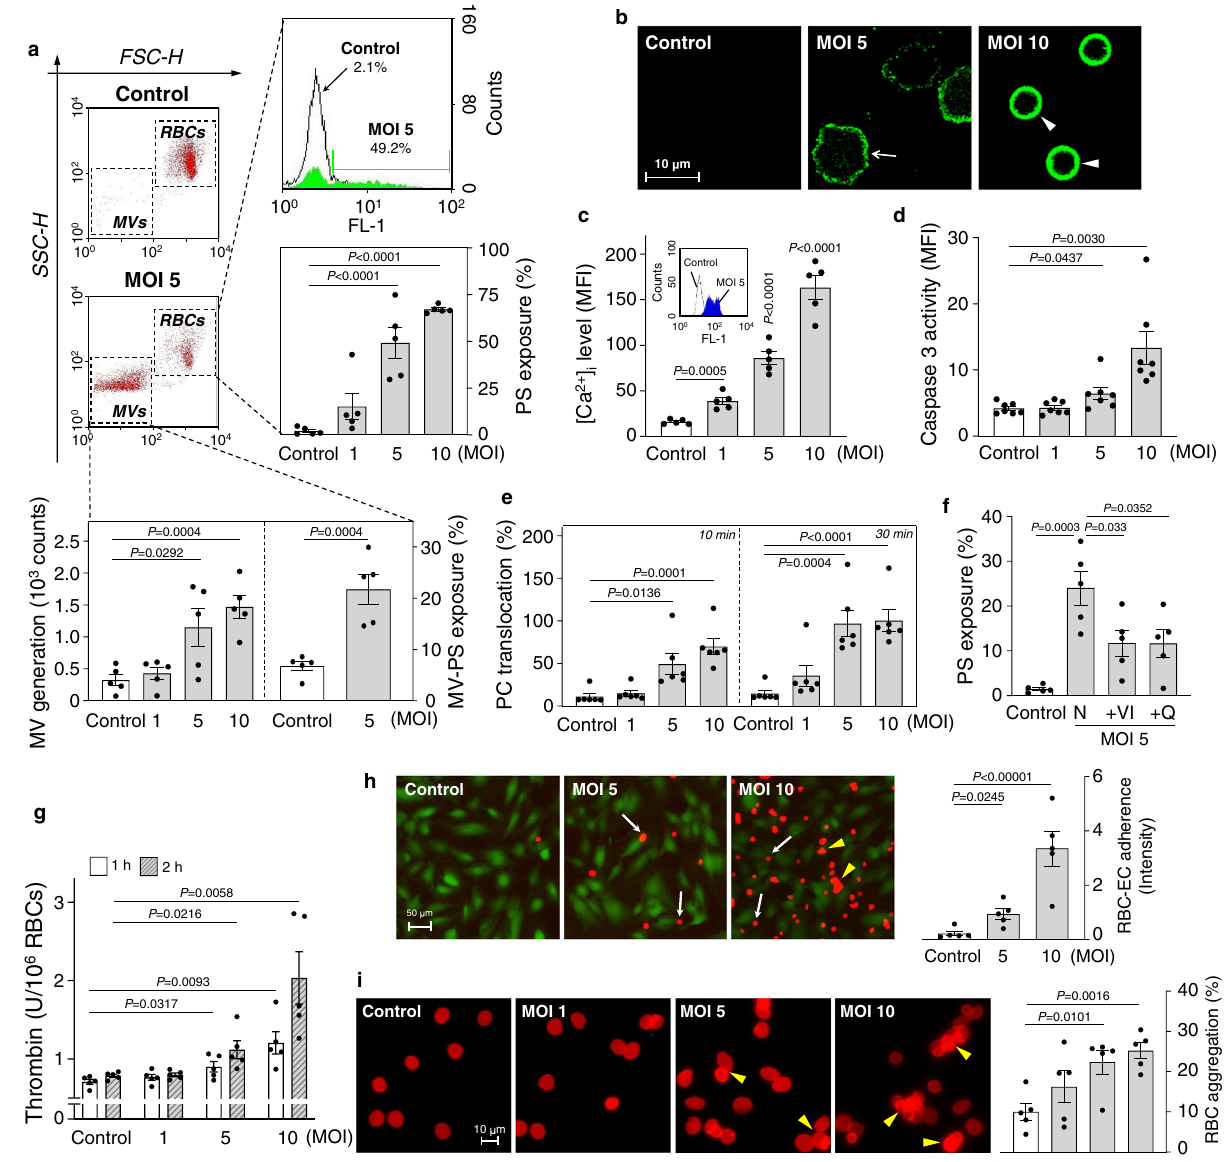
Fig. 2 | InfectionofhumanRBCswith V. vulni fi cus increases MVgeneration, PS exposure, and procoagulant and prothrombotic activity. a , b RBCs were infected with V. vulni fi cus at various MOIs and incubated for 1h. a RBCs and MV were separately analyzed based onforward-scatter height (FSC-H)and side-scatter height (SSC-H) by fl ow cytometry (top left). The extents of PS exposures of the RBCs are determined and presented as a histogram with fl uorescence FL-1 (top right) and as bar graphs (middle right) ( n =5, two-tailed Student ’ s t -test). Con- sistently, MV generated from RBC membranes (bottom left) and PS exposures of the MVs (bottom right) ( n =5, two-tailed Student ’ s t -test) are presented. b PS exposures of the RBCs stained with Annexin V-FITC were analyzed by confocal microscopy and different shapes of RBCs are marked with the same symbols used for Fig. 1c. The representative images among fi ve independent experiments were presented. The scale bar is presented. c Intracellular Ca 2+ [Ca 2+ ] i level in the RBCs infected with V. vulni fi cus for 1h are presented as bar graphs and as a histogram with fl uorescence FL-1 ( c , insert) ( n =5, two-tailed Student ’ s t -test). d – g RBCs were